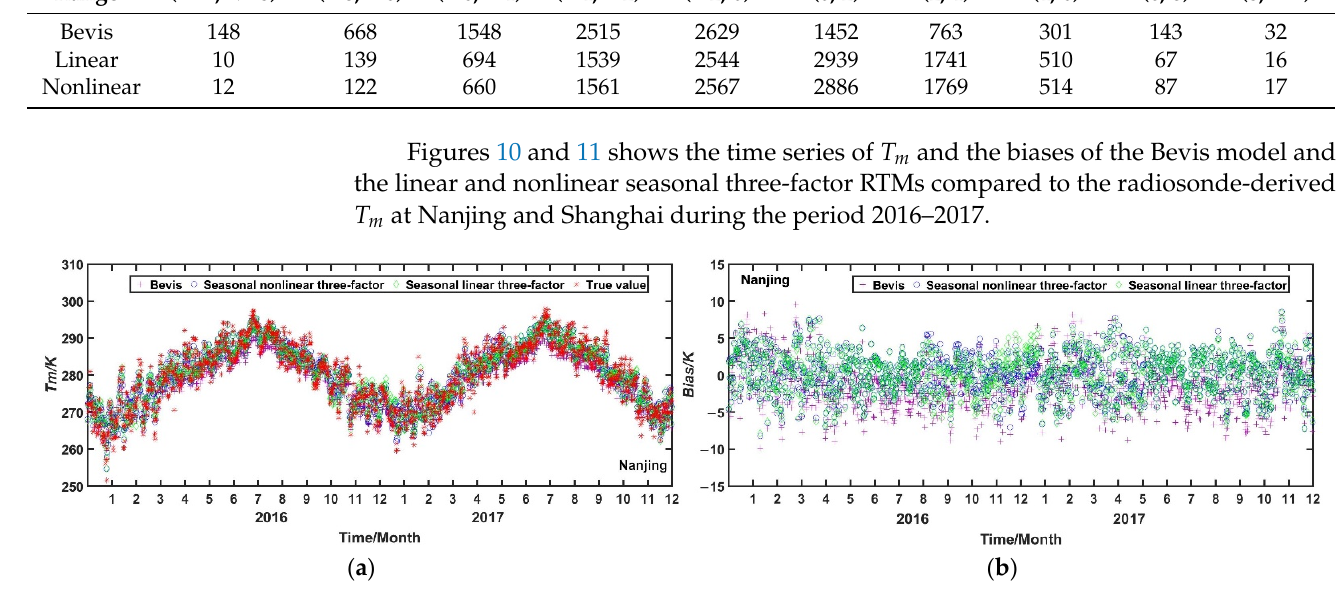
( b ) Figure 11. Time series of 𝑇 (cid:3040) ( a ) and the biases ( b ) of Bevis, linear and nonlinear seasonal three- factor RTMs to the radiosonde-derived 𝑇 (cid:3040) at Shanghai station during 2016–2017. Table 12. The biases and RMSE of the linear and nonlinear seasonal multifactor RTMs-derived 𝑇 (cid:3040) in the Yangtze River Delta region during 2016–2017 (K). Models